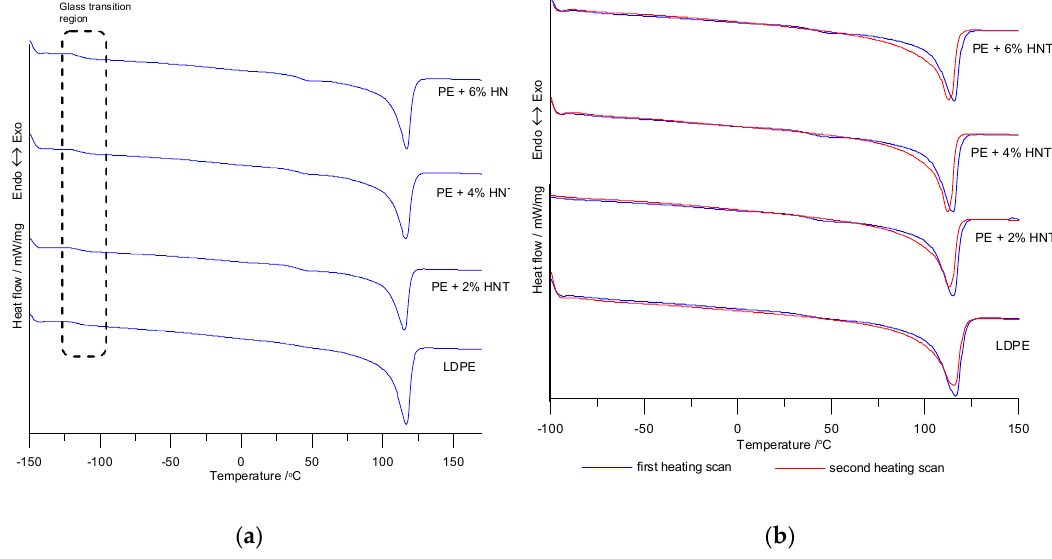
Figure 2. DSC curves from heating: ( a ) Heating from − 150 ◦ C to 170 ◦ C and ( b ) two heating scans from − 100 ◦ C to 150 ◦ C.